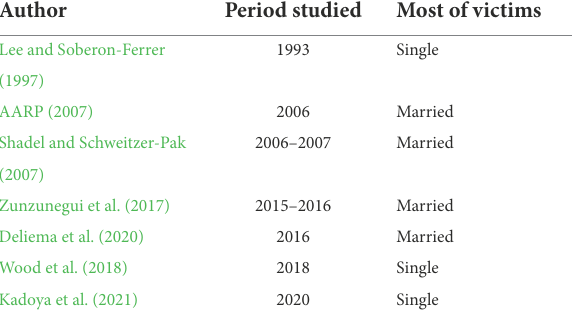
TABLE 4 Profiles of victims according to marital status across time.